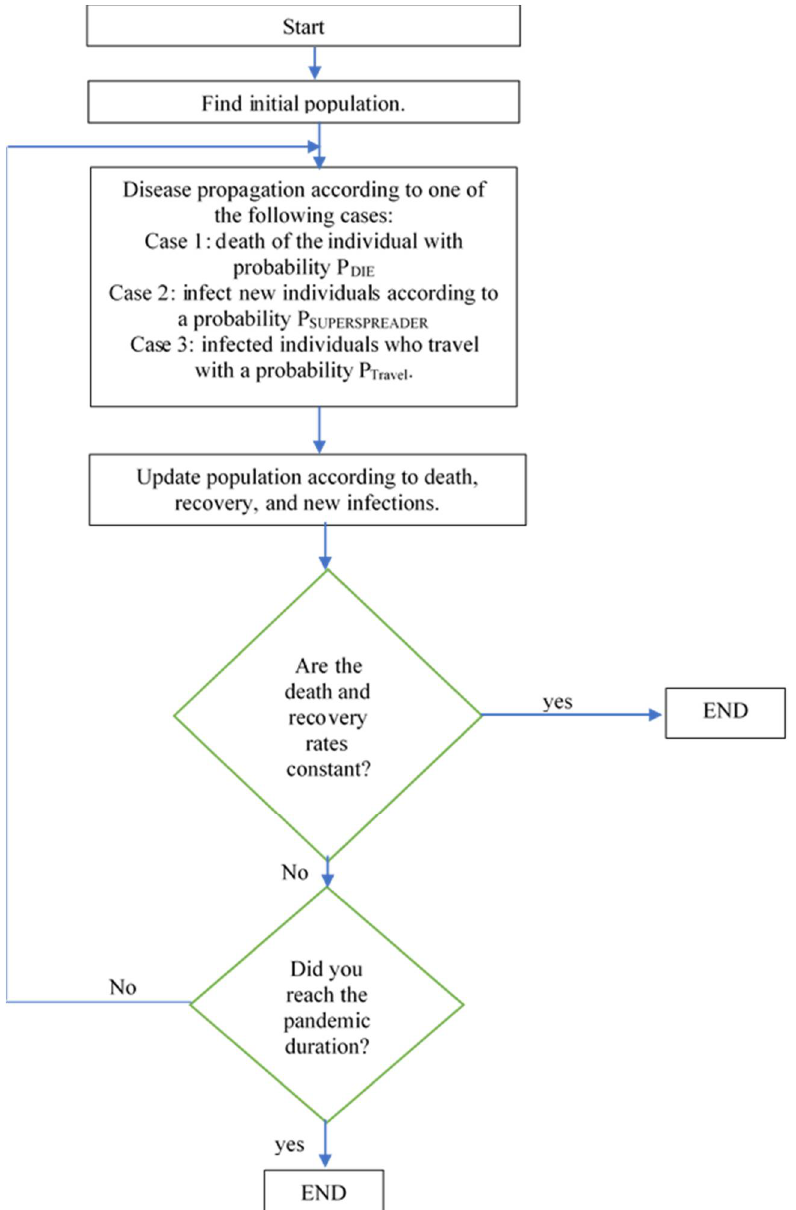
Figure 5. CVO flowchart .